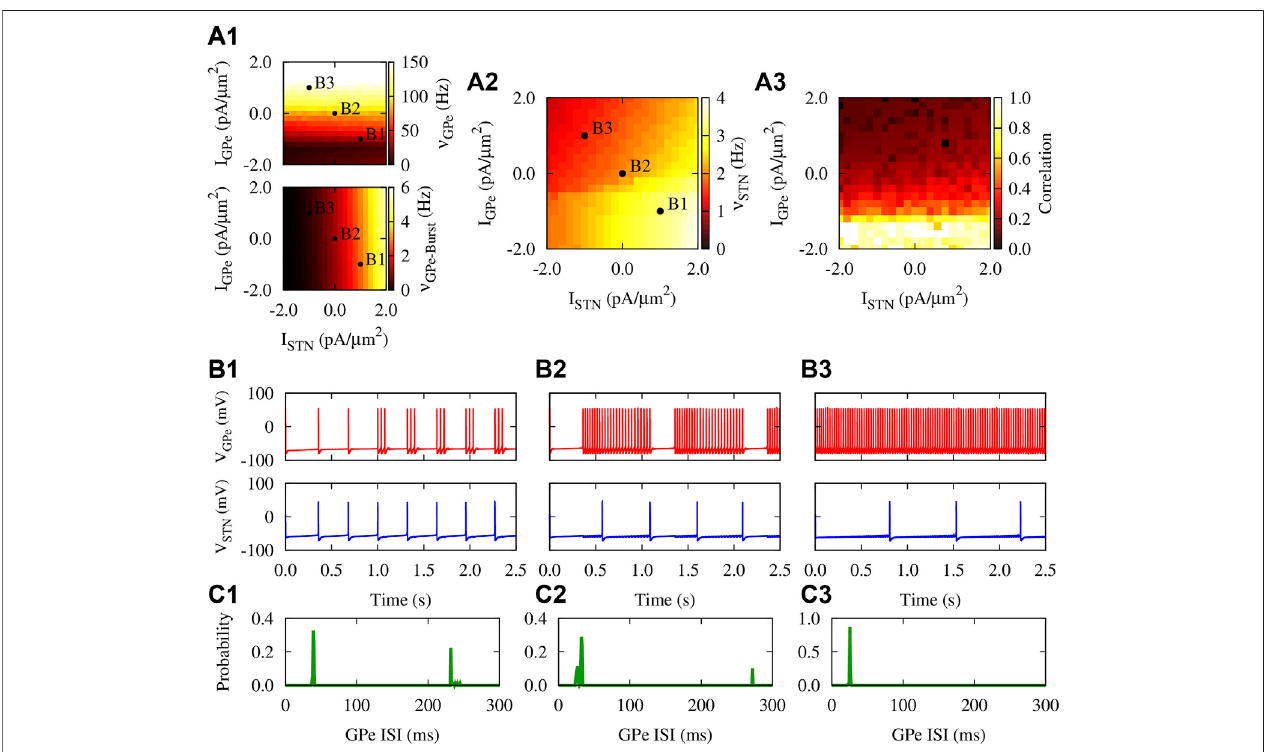
FIGURE2| FiringpropertiesoftheGPe-STNmotifwithstaticsynapses. (A1 – A3) Mean fi ringrate[ (A1) ,top]andburstfrequency[ (A1) ,bottom]oftheGPeneuron, mean fi ring rateofthe STN neuron (A2) , and thepairwise correlation between theirspikingactivity (A3) asafunction ofapplied currents when g SG = g GS =0.25 nS/ μ m 2 . The burstfrequency fortheGPe neuronwascalculated byconsidering the fi rstspike ineach burst. (B1 – B3) Threeexamplarytimecourses ofthe membrane potentialof reciprocally connected GPe (top) and STN (bottom) neurons subjected to different applied currents: (B1) I GPe = − 1.0 pA/ μ m 2 , I STN = 1.0 pA/ μ m 2 (B2) I GPe = I STN